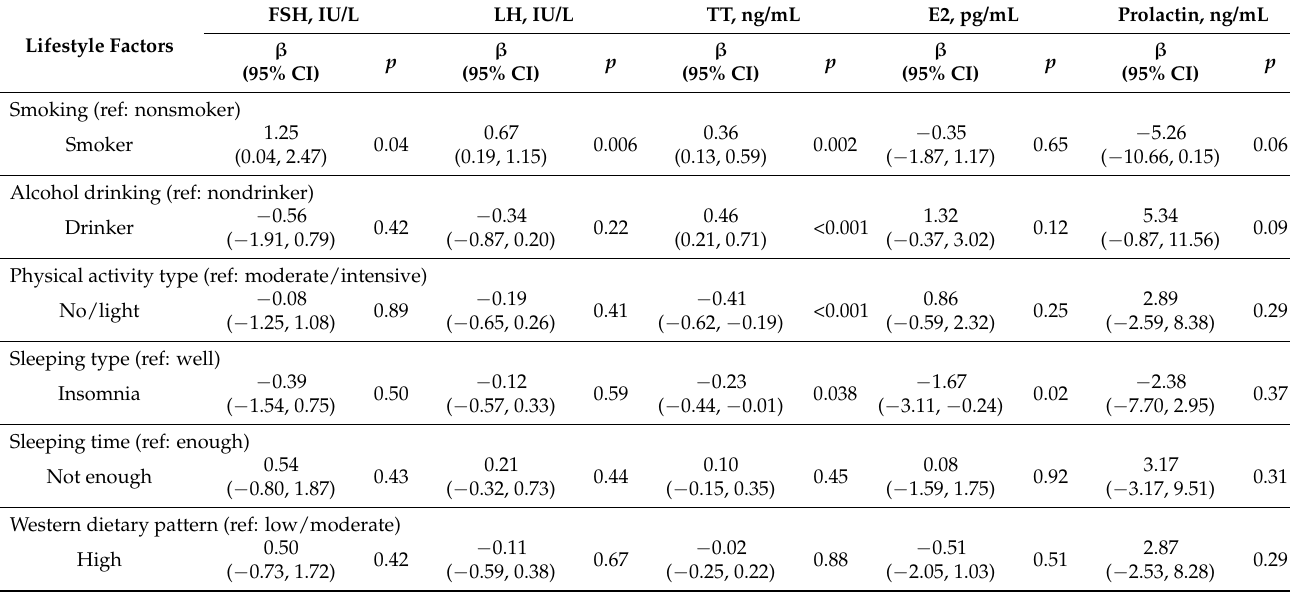
Table 3. Adjusted beta ( β ) coefficient and 95% confidence intervals (CIs) of sex hormones according to lifestyle behaviors.